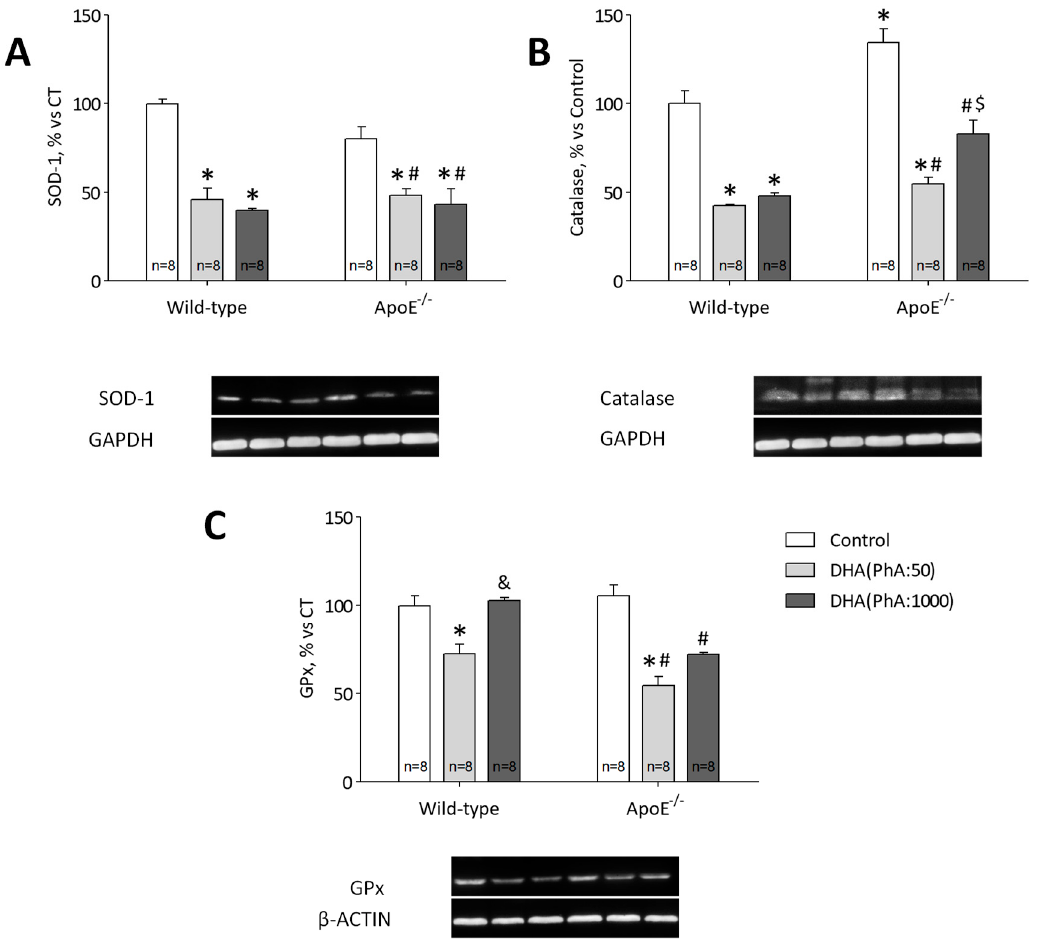
Figure 8. Effects of DHA (PhA:50) and DHA (PhA:1000) on relative protein expression of ( A ) superoxide dismutase 1 (SOD-1), ( B ) catalase, and ( C ) glutathione peroxidase (GPx) in hippocampus of ApoE − / − and wild-type mice. Data show mean ± SEM. * p < 0.05 compared to control wild-type mice; # p < 0.05 compared to control ApoE − / − mice; & p < 0.05 compared between DHA (PhA:50) and DHA (PhA:1000) in wild-type mice; $ p < 0.05 compared between DHA (PhA:50) and DHA (PhA:1000) in ApoE − / − mice. ( n =